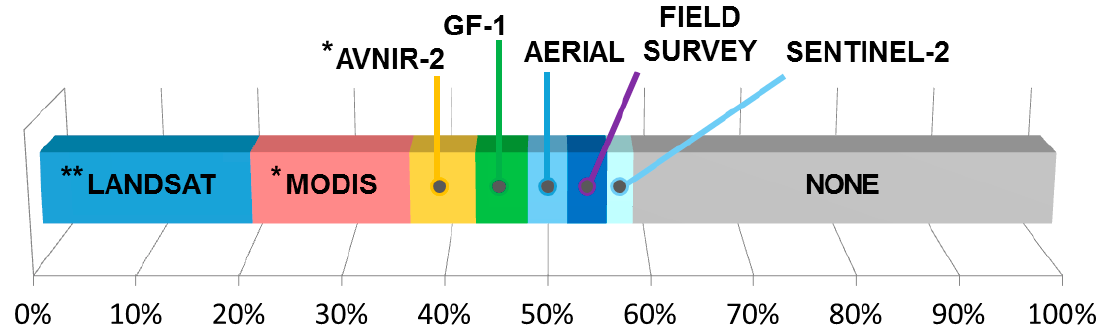
Figure 10. External/Ground truth data used for validating SAR-based snow cover products. * Advanced visible and near infrared radiometer type 2 (AVNIR-2) sensor onboard on Advanced land observation satellite (ALOS) satellite; moderate resolution imaging spectroradiometer (MODIS) sensor onboard on Terra and Aqua satellites; ** Landsat-series missions compose different optical sensors.